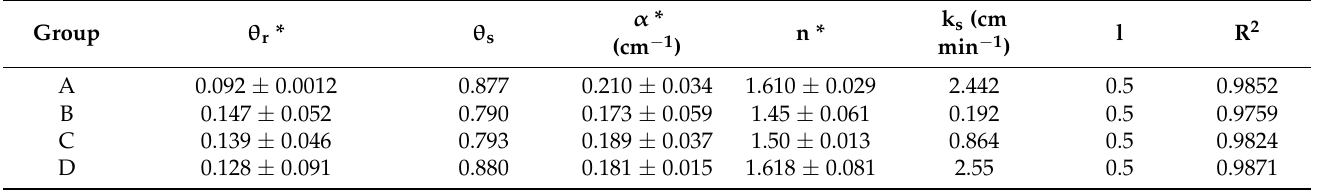
Table 3. Hydraulic parameters of waste VGM model with different properties ( ± values are 95% confidence interval).